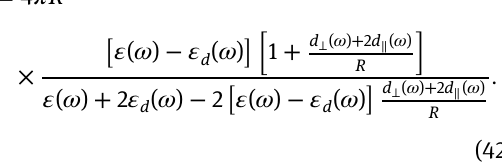
along the triangle altitude in (d). Roundingis intramural and of a cylindrical and spherical kind with inscribed diameters equaling the specified rounding value. Figure reproduced from Ref. [122] ( © 2017 American Physical